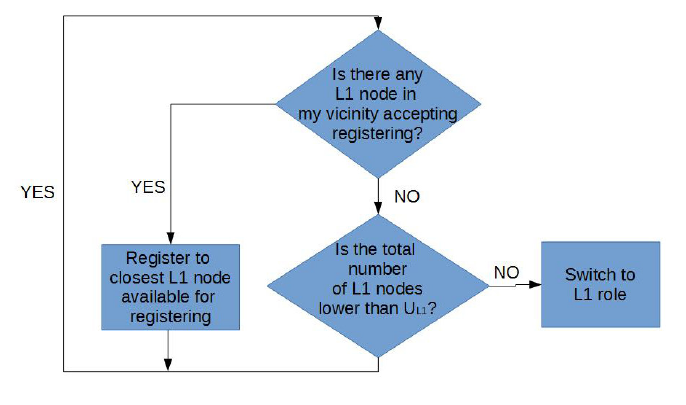
Figure 1. Role definition algorithm for Level 0 (L0)